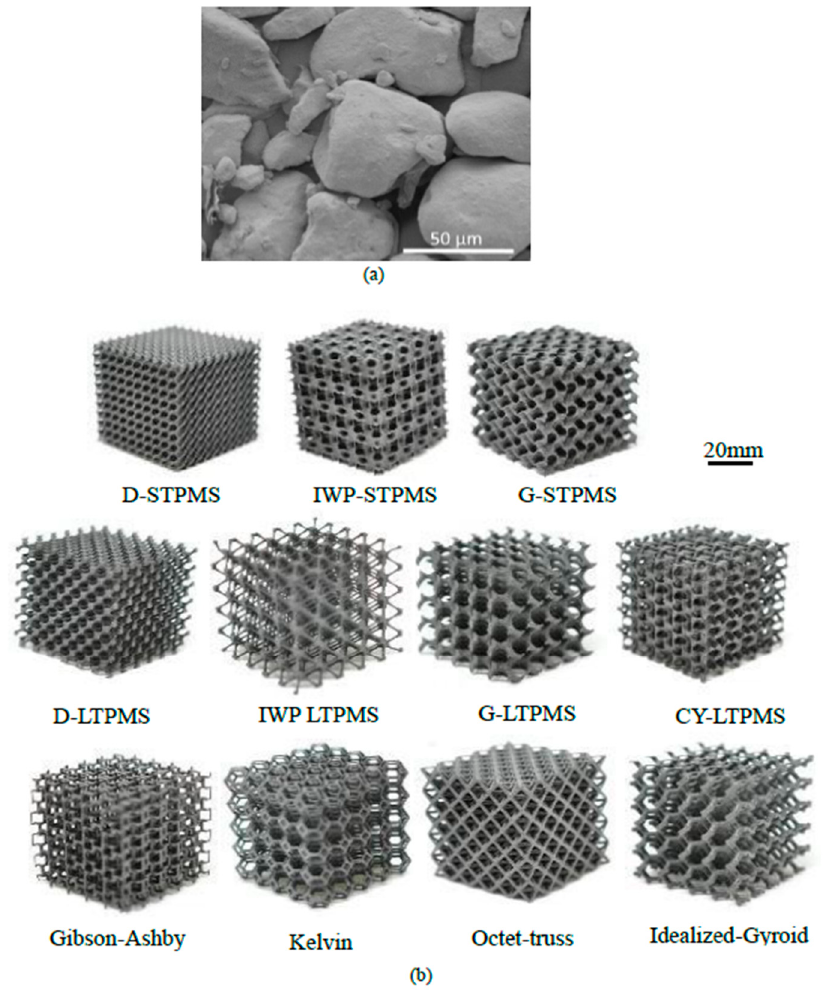
Figure 2. ( a ) SEM image of the shape and size of the base PA1102 black powder. ( b ) Samples 3D- printed by SLS technique of different cellular topologies; sheet-based TPMS (top), ligament-based TPMS (middle), and cellular struts (bottom) with 5 unit cell periodicity and 8 mm unit cell size.